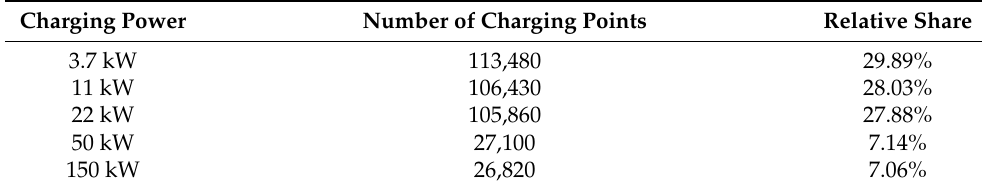
Table 9. Charging points per power of the top-edge solution.